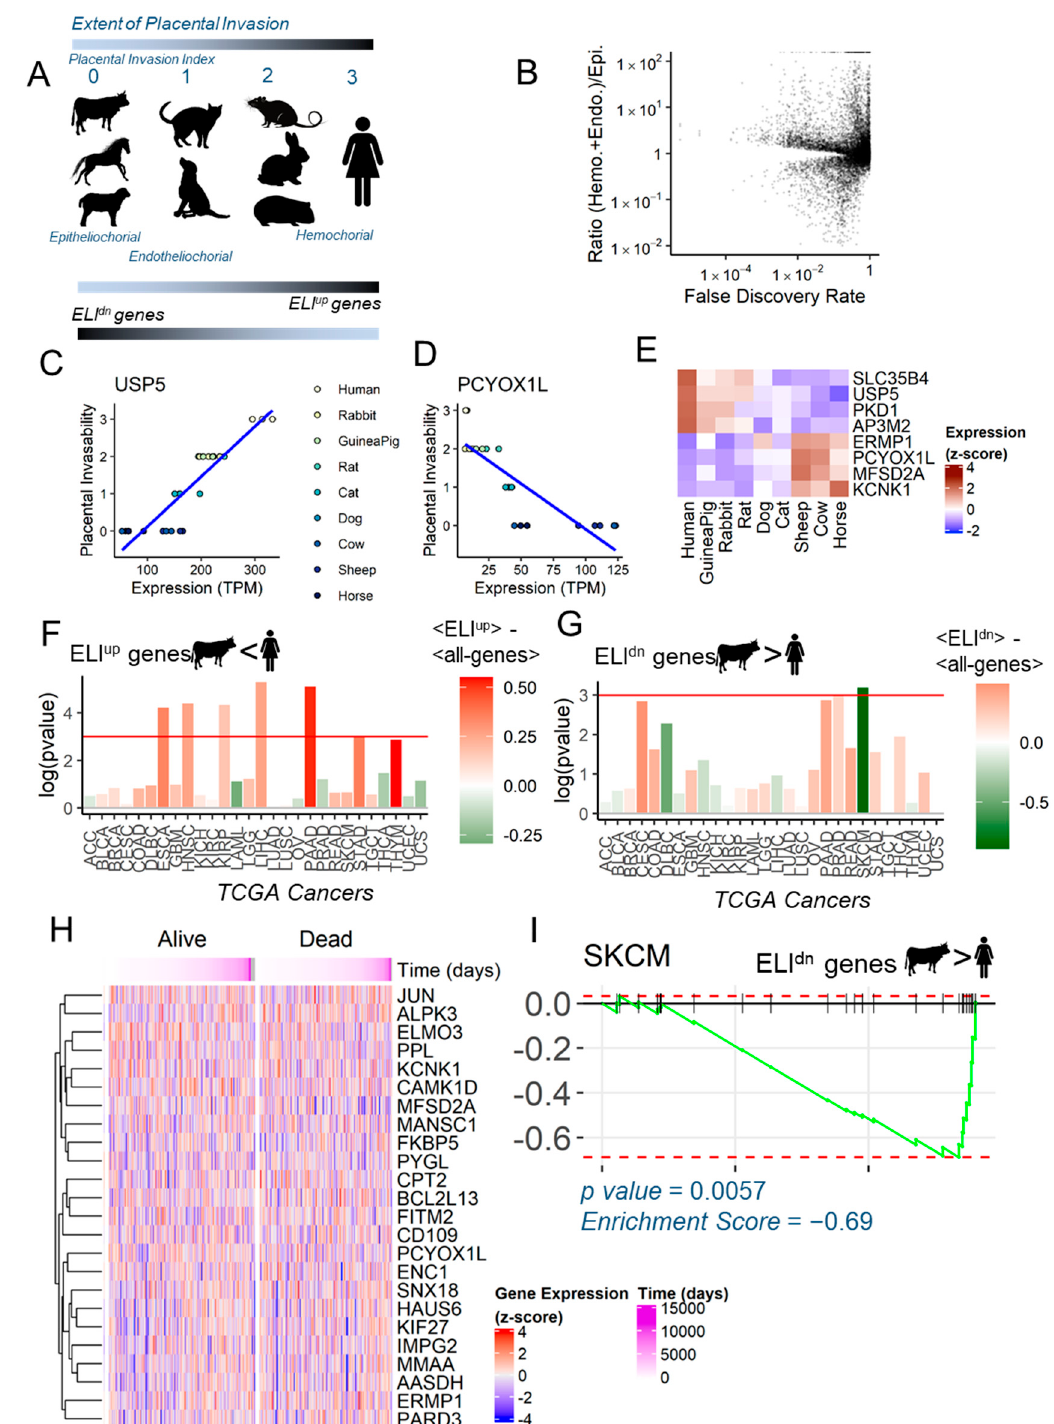
Figure 1. Evolved Levels of Invasability (ELI) in mammals and its signature in human cancer. ( A ) The extent of physiological placental invasion differ among depicted mammals, rated manually as shown between 0 and 3. Using a phylogenetic linear regression model, genes significantly correlated with increased invasion were termed ELI up , while those anti-correlated with invasion were termed ELI dn . ( B ) Global view of the genes and their statistical test for correlation to placental invasion ( x -axis), and the ratio of expression in hemochorial and endotheliochorial species vs. in epitheliochorial species. ( C , D ) Examples of individual genes USP5 and PCYOX1L, whose expression across species ( x -axis) is correlated (positively and negatively, respectively) with the extent of placental invasion ( y -axis). ( E ) Heat map showing the relative expression (z-scores) of four ELI up and four ELI dn genes across species. ( F , G ) Overall differential expression of ELI up and ELI dn gene data derived from Gene Expression Profiling Interactive Analysis (GEPIA), respectively, in different cancers represented in The Cancer Genome Atlas (TCGA). T-tests were conducted for the difference between ELI up or ELI dn and all other genes